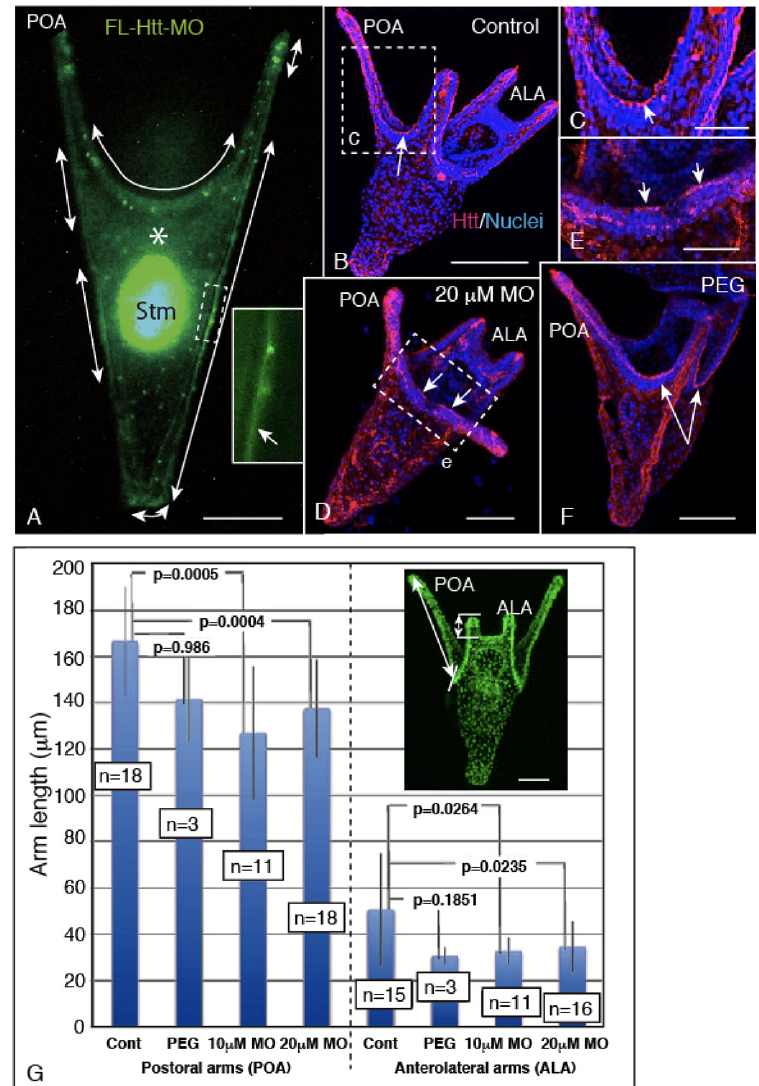
Figure 4. Shortened larval arm length in Fluorescein-tagged Hp-Htt morpholino ( FL-Htt-MO )-treated 4aPL. ( A ) Fluorescence microscopy of FL-Htt-MO -positive areas (green) in the stomach (Stm), the ectoderm regions (double-headed arrows), and the blastocoelar space (asterisk). Inset: Higher magnification of green glow cytoplasmic region of the ectoderm (arrow) of the larval trunk, shown by a dotted-line rectangle. ( B – F ) Confocal microscopies double-stained for Htt (red) and nuclei (blue). ( B ) Control larva. Hp-Htt was detected at the CBAS (arrow). ( C ) Higher magnification image of a doted-line rectangle (c) in ( B ) shows CBAS by an arrow. ( D ) 20 µ M FL-Htt-MO -treated larva. Larval arms are distinctively shorter than those in the control larva and CBAS was fragmented (arrows). ( E ) Higher magnification image of a dotted-line rectangle (e) in ( D ). The Hp-Htt-positive area shows a fragmented CBAS (arrows). ( F ) PEG-treated larva extends normal length arms with continuous Hp-Htt-positive signal in CBASs (arrows). ( G ) Statistical analysis of the arm length shown by columns with error bars depicting the shortened arm length in the FL-Htt-MO -treated larvae. The number of larvae examined is indicated in boxes in the middle of each column. p values were calculated between the two columns connected with solid lines. Inset: The dorsal view of a pseudo-green-colored DAPI-stained larva shows places that were subjected to measurement of the arm length with double-headed arrows. Scale bars = 50 µ m ( A , G inset), 100 µ m ( B ), 25 µ m ( C , E ), 75 µ m ( D , F